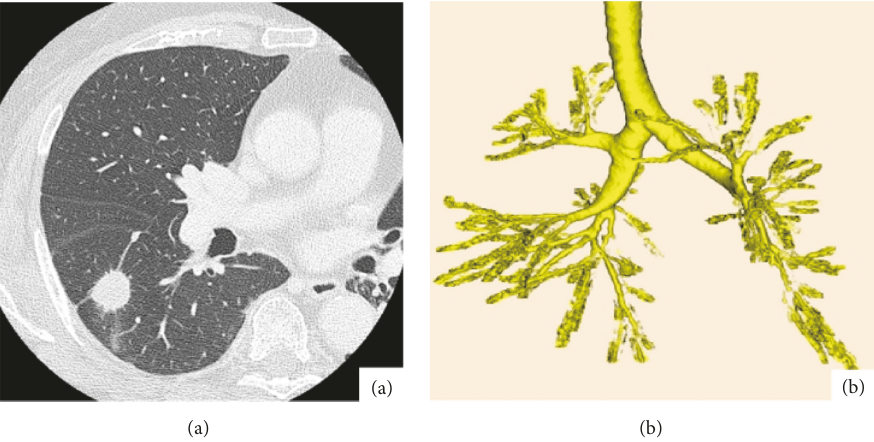
Figure 1: (a) Chest computed tomography (CT) showing a 1.8 cm, irregular nodular lesion in the right lower pulmonary lobe. (b) Three- dimensional CT showing normal bronchial anatomy.